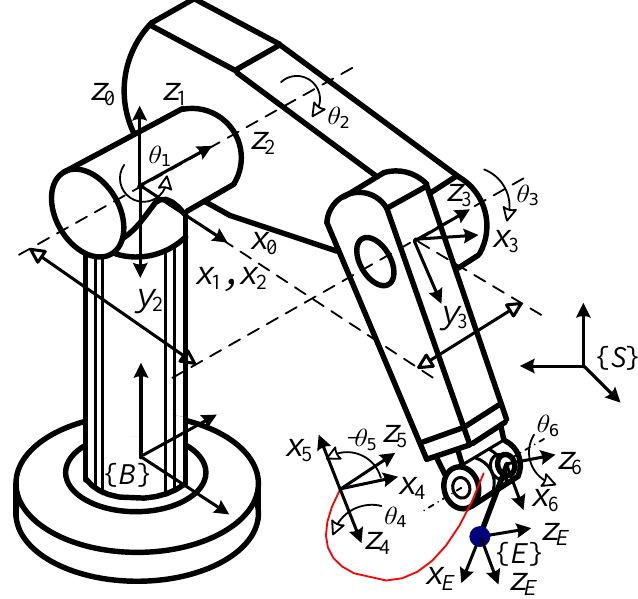
Figure 3. Robot PUMA and fixed link frames.